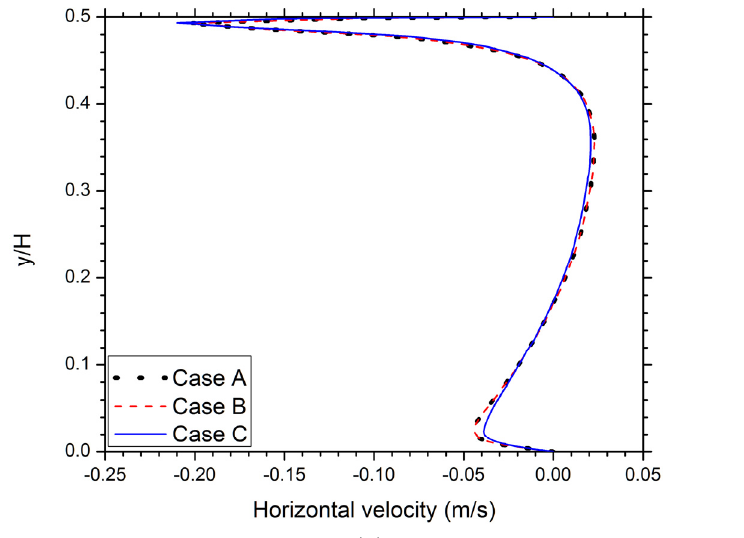
Figure 2. Predicted profiles of ( a ) horizontal velocity along the vertical line x = 2 m and ( b ) temperature along the symmetric line x = 0 for gird and time-step dependence test cases defined in Table